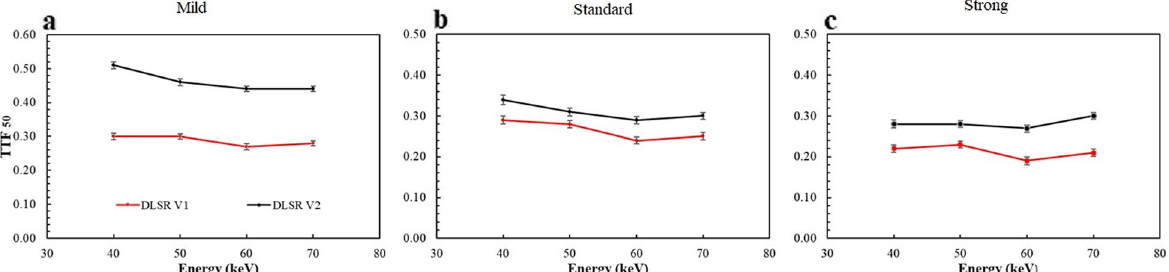
Fig. 4 Task‑based transfer function at 50% (TTF 50 ) as function of the energy levels for three levels of deep learning spectral reconstruction (DLSR) versions (DLSR V1 and DLSR V2). a Mild level. b Standard level. c Strong